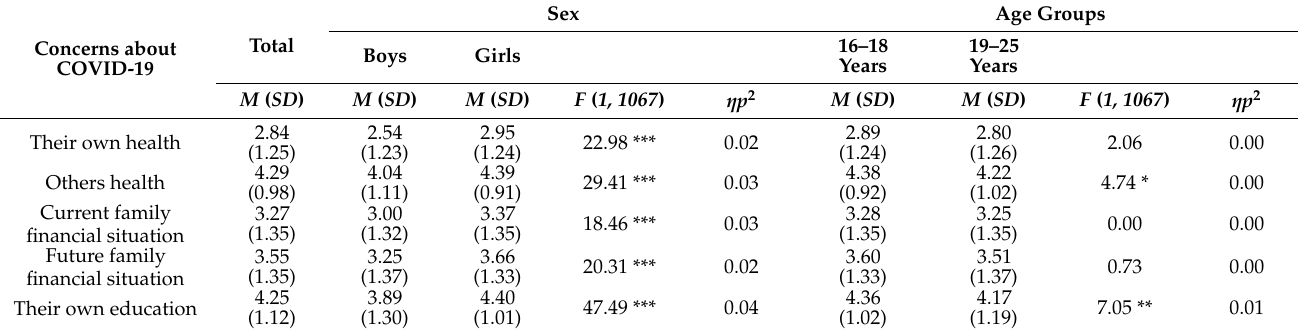
Table 1. Descriptive and MANOVA statistics for adolescents’ concerns by sex and age